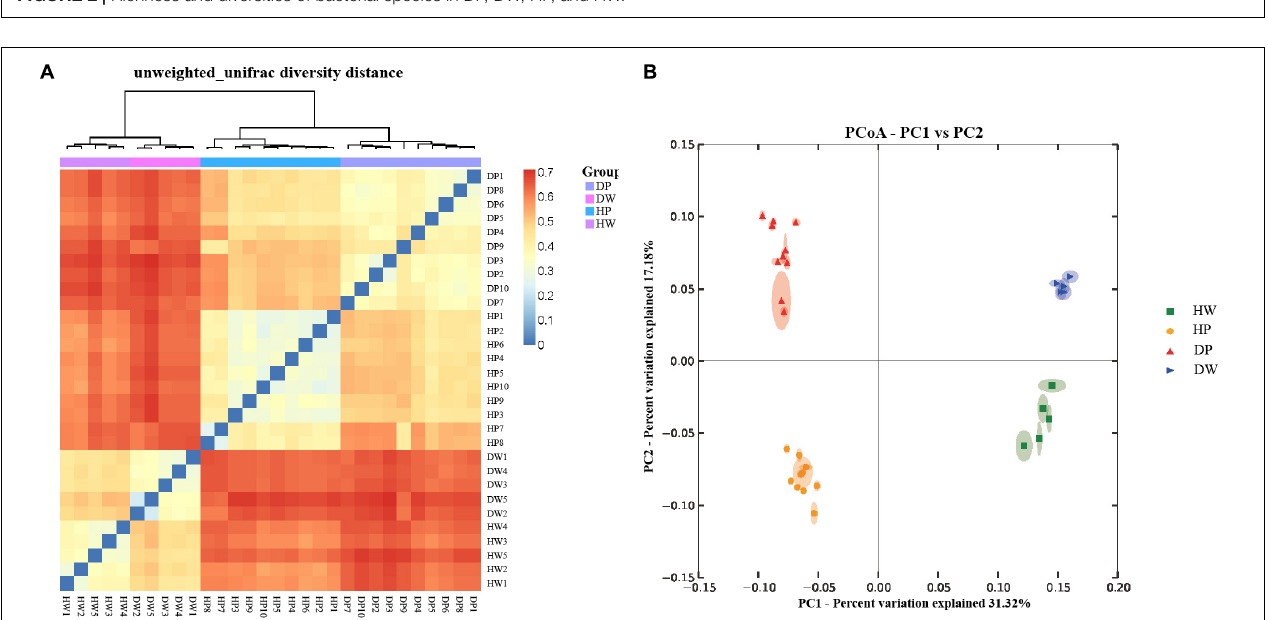
FIGURE 3 | Hierarchical clustering tree (A) and principal coordinate analysis (PCoA) of the bacterial community (B) on the OTU level. The hierarchical clustering tree was calculated using the unweighted pair-group method with arithmetic mean (UPGMA) method, and the relationship between samples was determined using Bray distance and the average clustering